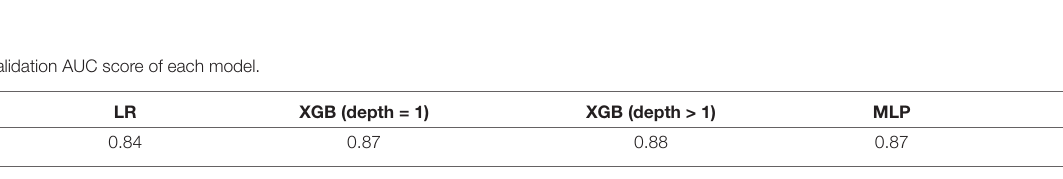
FIGURE 1 | The distribution of Troponin (left) and Temperature (right) over the CS, septic/hypovolemic shock, and non-shock groups.